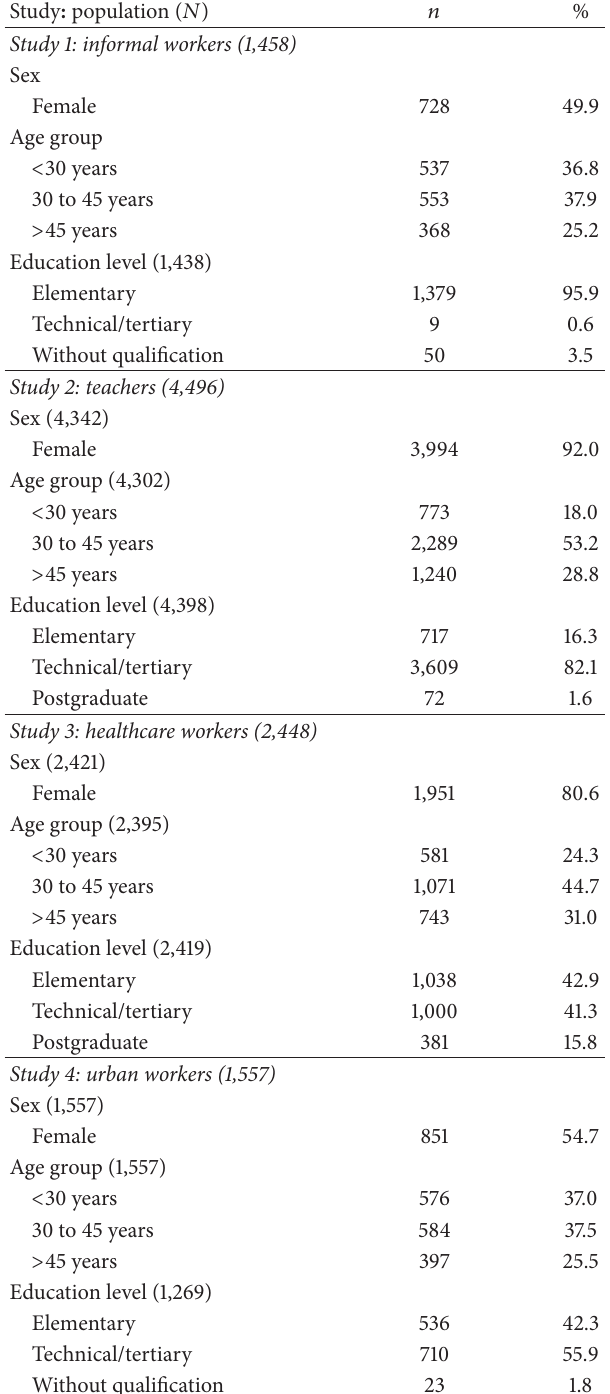
Table 1: Sociodemographic characteristics of the populations of the four